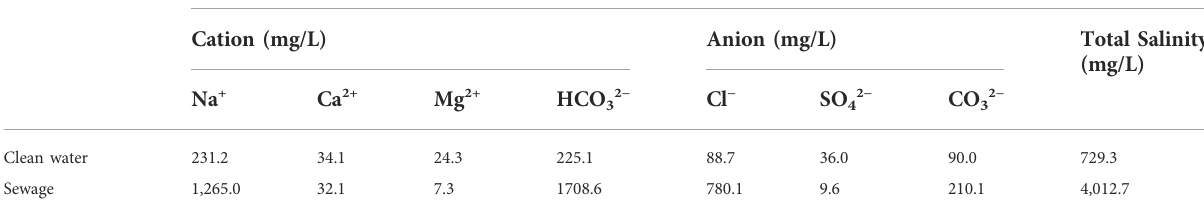
TABLE 1 ionic composition of experimental water.